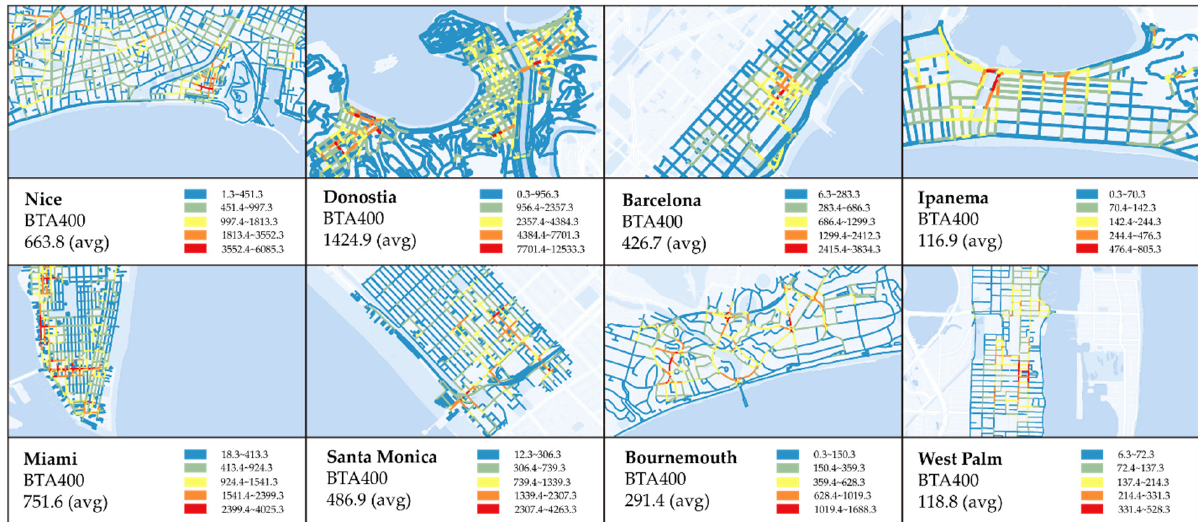
Figure 5. The analytical results of BTA 400 in successful coastal cases.